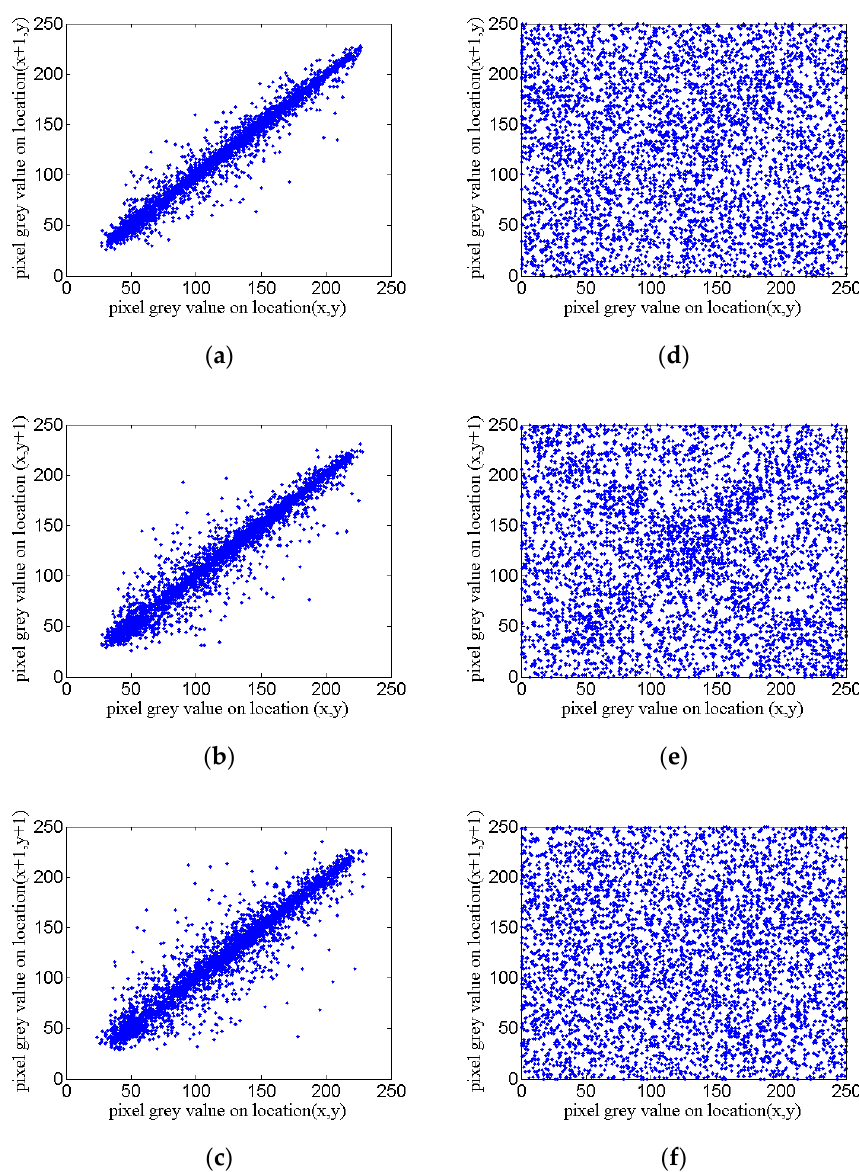
Figure 12. The comparison tests of correlation coefficient before and after Lena image encryption: ( a ) the horizontal correlation coefficient before encryption; ( b ) the vertical correlation coefficient before encryption; ( c ) the diagonal correlation coefficient before encryption; ( d ) the horizontal correlation coefficient after encryption; ( e ) the vertical correlation coefficient after encryption; ( f ) the diagonal correlation coefficient after encryption.